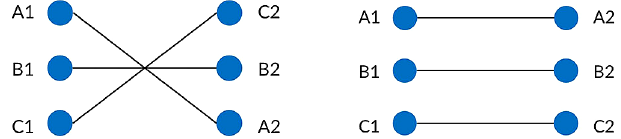
Figure 4. Double circuit phase configuration for standard transposed phasing (left) and un-transposed phasing (right).